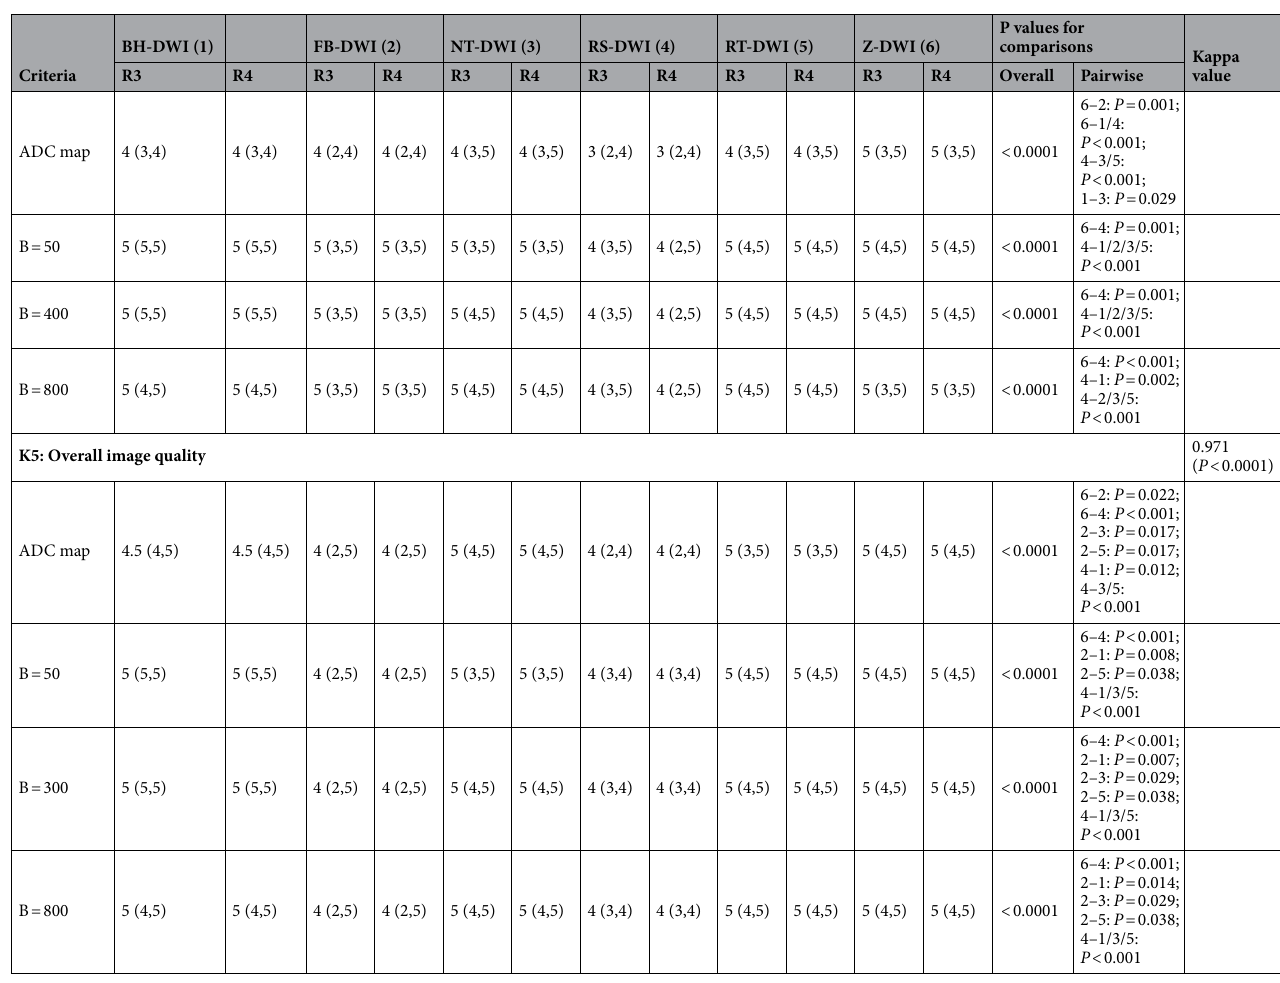
Table 5. The evaluation of image quality in volunteer by reader 3(R3) and reader 4(R4). Median (min, max) values for the mean image quality ratings calculated are given separately for the three different b-values as well as for the ADC map. 5 = excellent, 4 = good, 3 = moderate, 2 = fair, 1 = nondiagnostic. On the right, P -values for the overall comparisons using Friedman test are given. If the Friedman test showed a statistically significant P -value, the Dunn-Bonferroni post-hoc test for all pairwise comparisons was performed. P < 0.05 were considered significant difference. P values were presented only when they were less than 0.05. BH-DWI breath- hold DWI, FB-DWI free-breathing DWI, NT-DWI navigator-triggered DWI, RS-DWI readout-segmented DWI, RT-DWI respiratory- triggered DWI and Z-DWI Zoomit